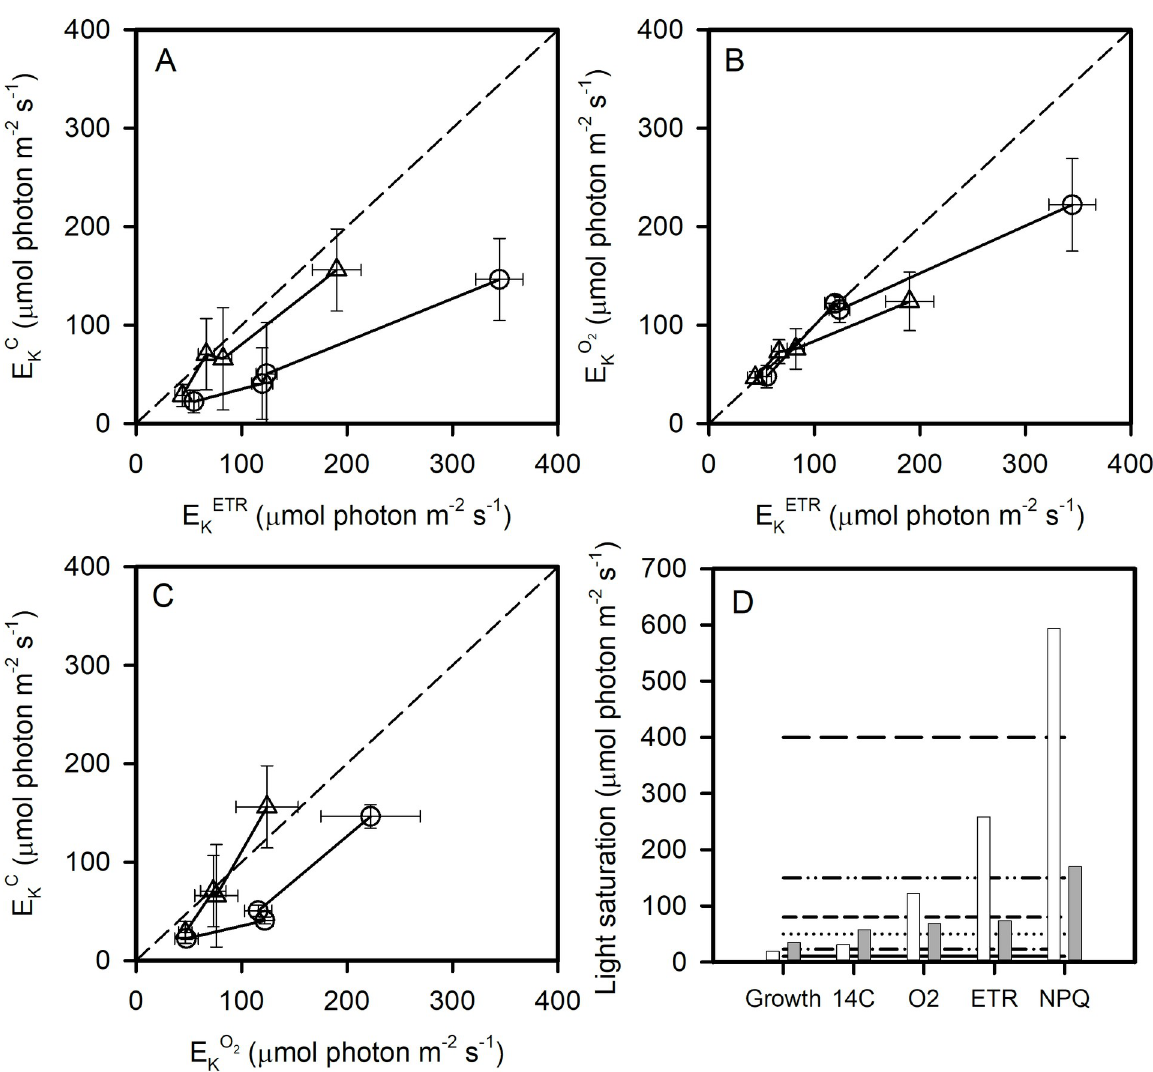
Fig 5. E KC versus E KETR (A), E KO 2 versus E KETR (B) and E KC versus E KO 2 (C) at 0˚C (circles) and 5˚C (triangles). In A, B, C, the dotted lines represent the 1:1 line. The growth irradiance at which growth rate ( μ ), carbon fixation ( 14 C), O 2 net production, ETR and NPQ saturate (E = E Ki ) is presented in D at 0˚C (white bars) and 5˚C (grey bars). In D, horizontal lines indicate growth irradiances (10, 23, 50, 80, 150, 400 μ mol photon m -2 s -1